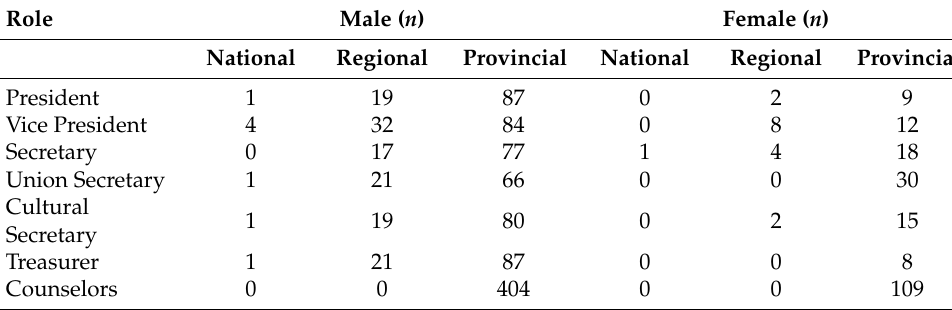
Table 4. Roles in national, regional, and provincial ANDI boards.